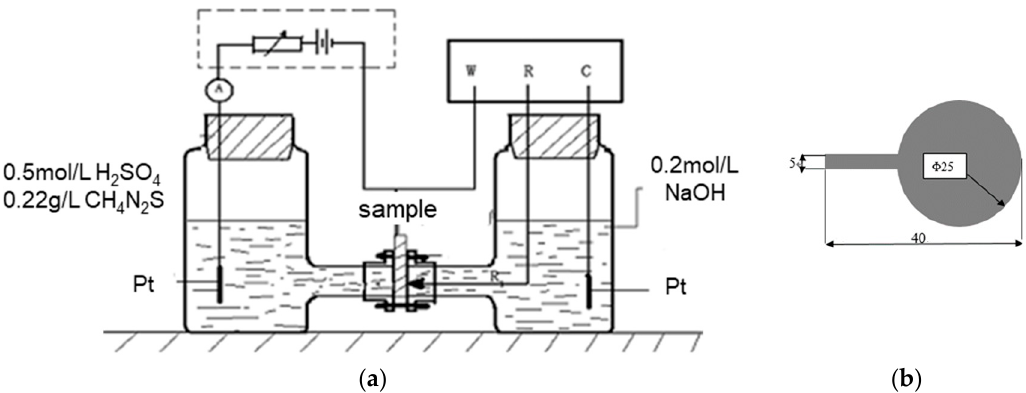
Figure 2. ( a ) Devanathan–Stachurskidouble electrode cells used for hydrogen charging test, ( b ) Geometry of tested specimen with 0.3 mm